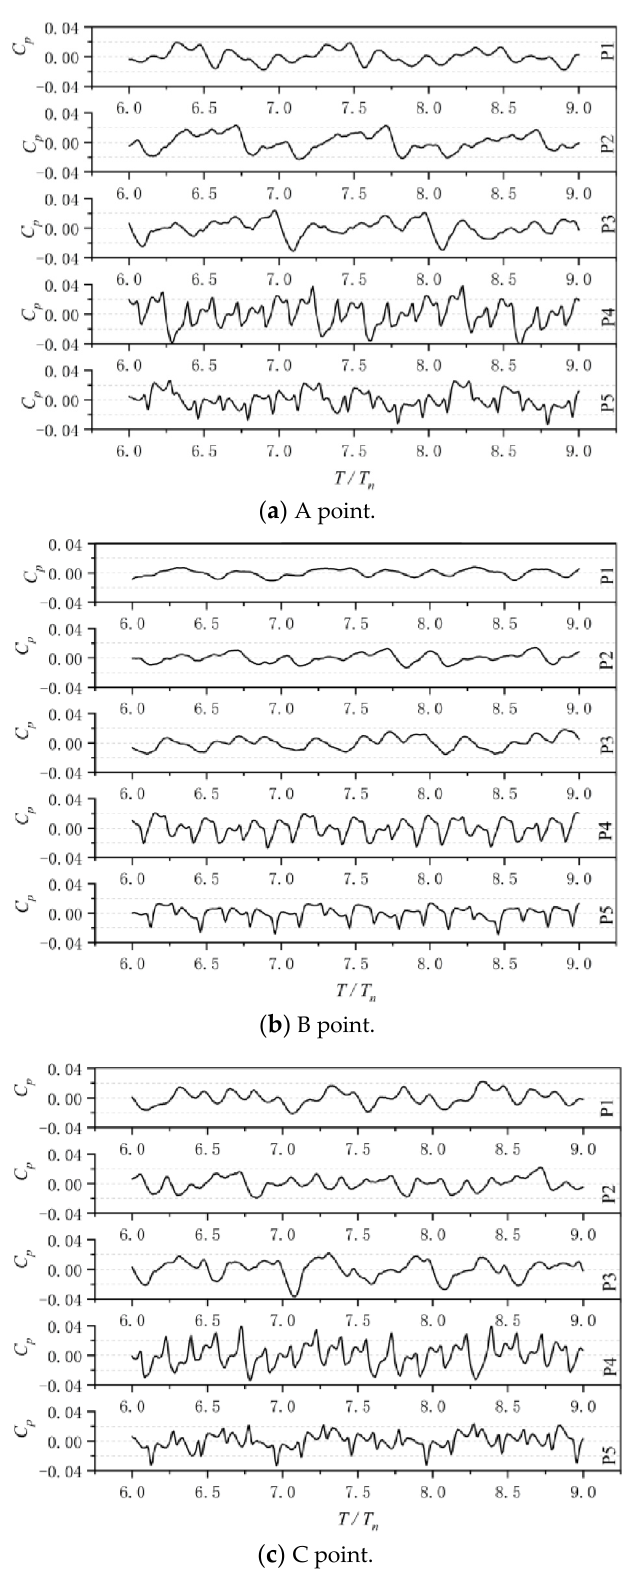
Figure 14. Pressure time domain in the volute.